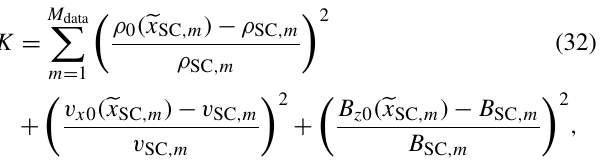
solar wind transit time across the subsolar